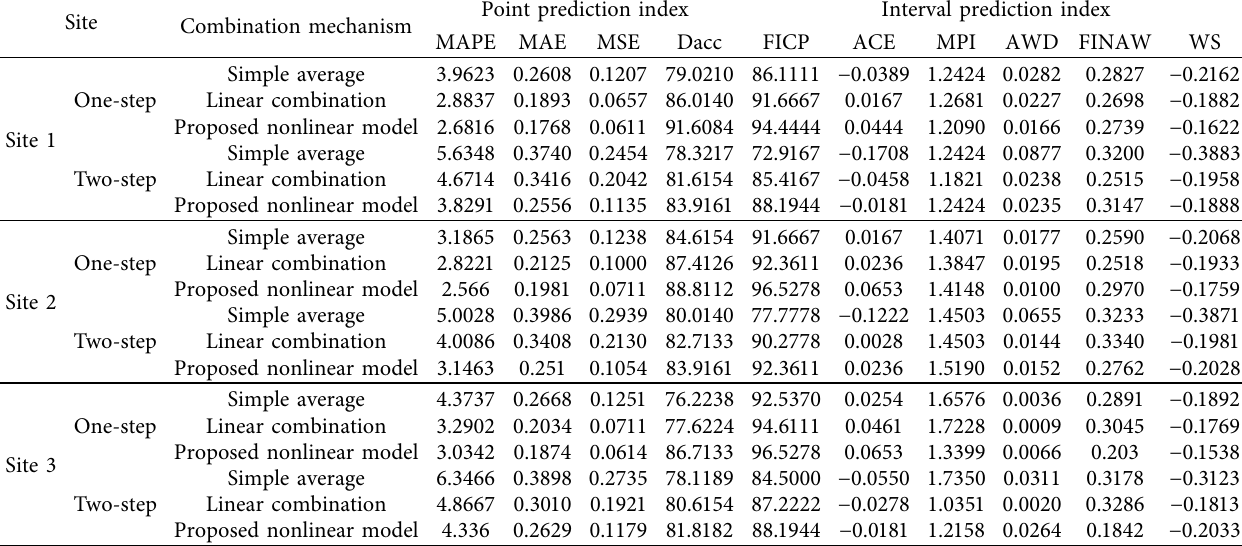
Table 9: Comparison of three different combination mechanisms.